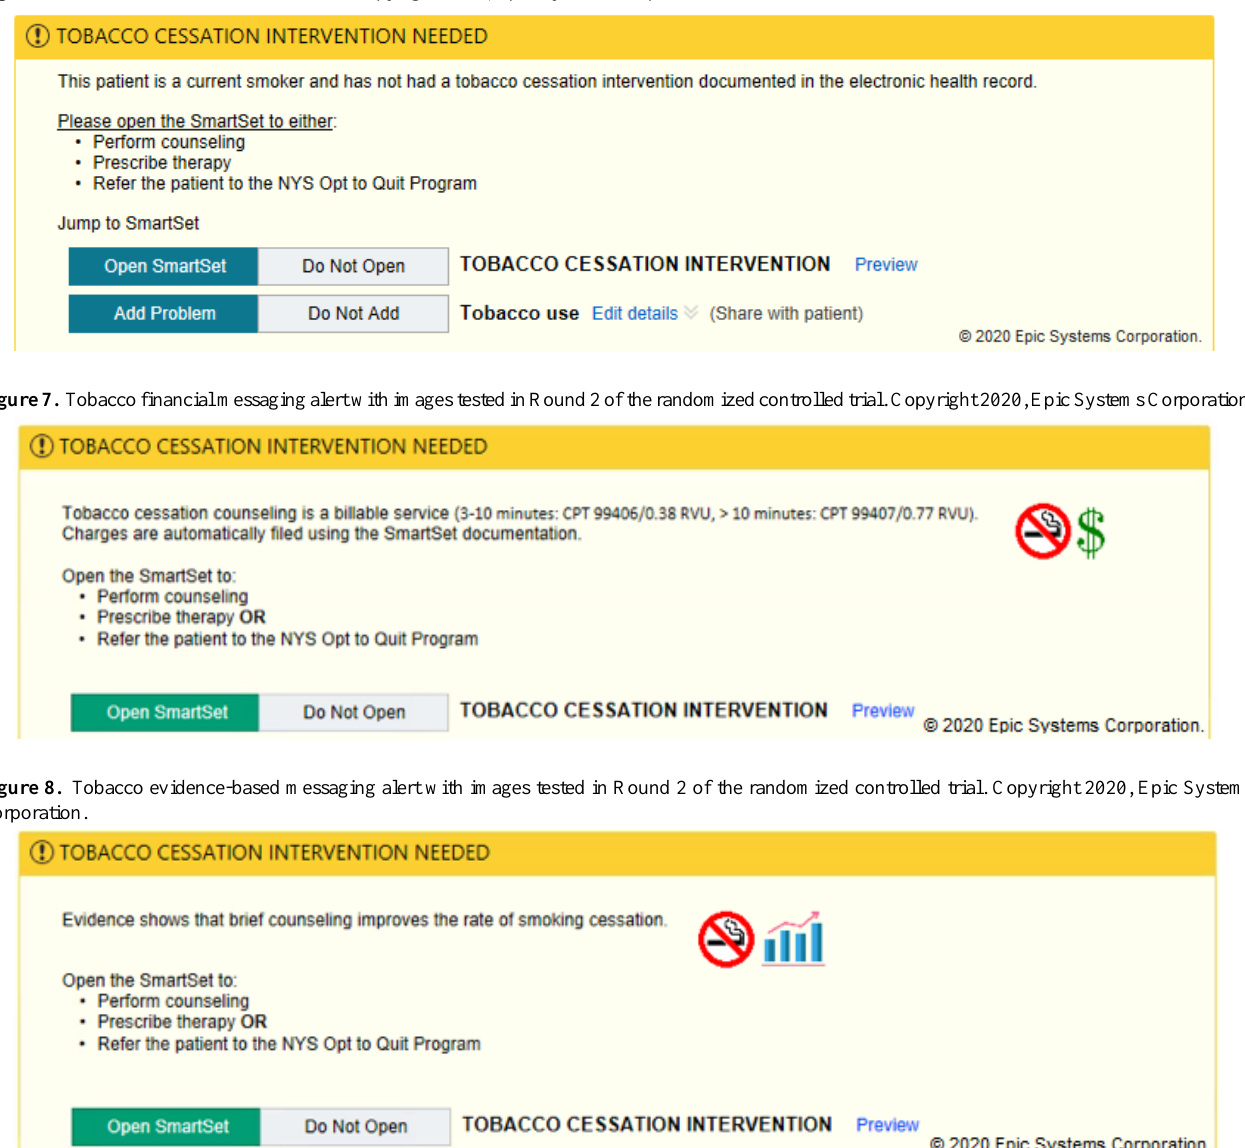
Figure 6. Baseline tobacco cessation alert. Copyright 2020, Epic Systems Corporation.